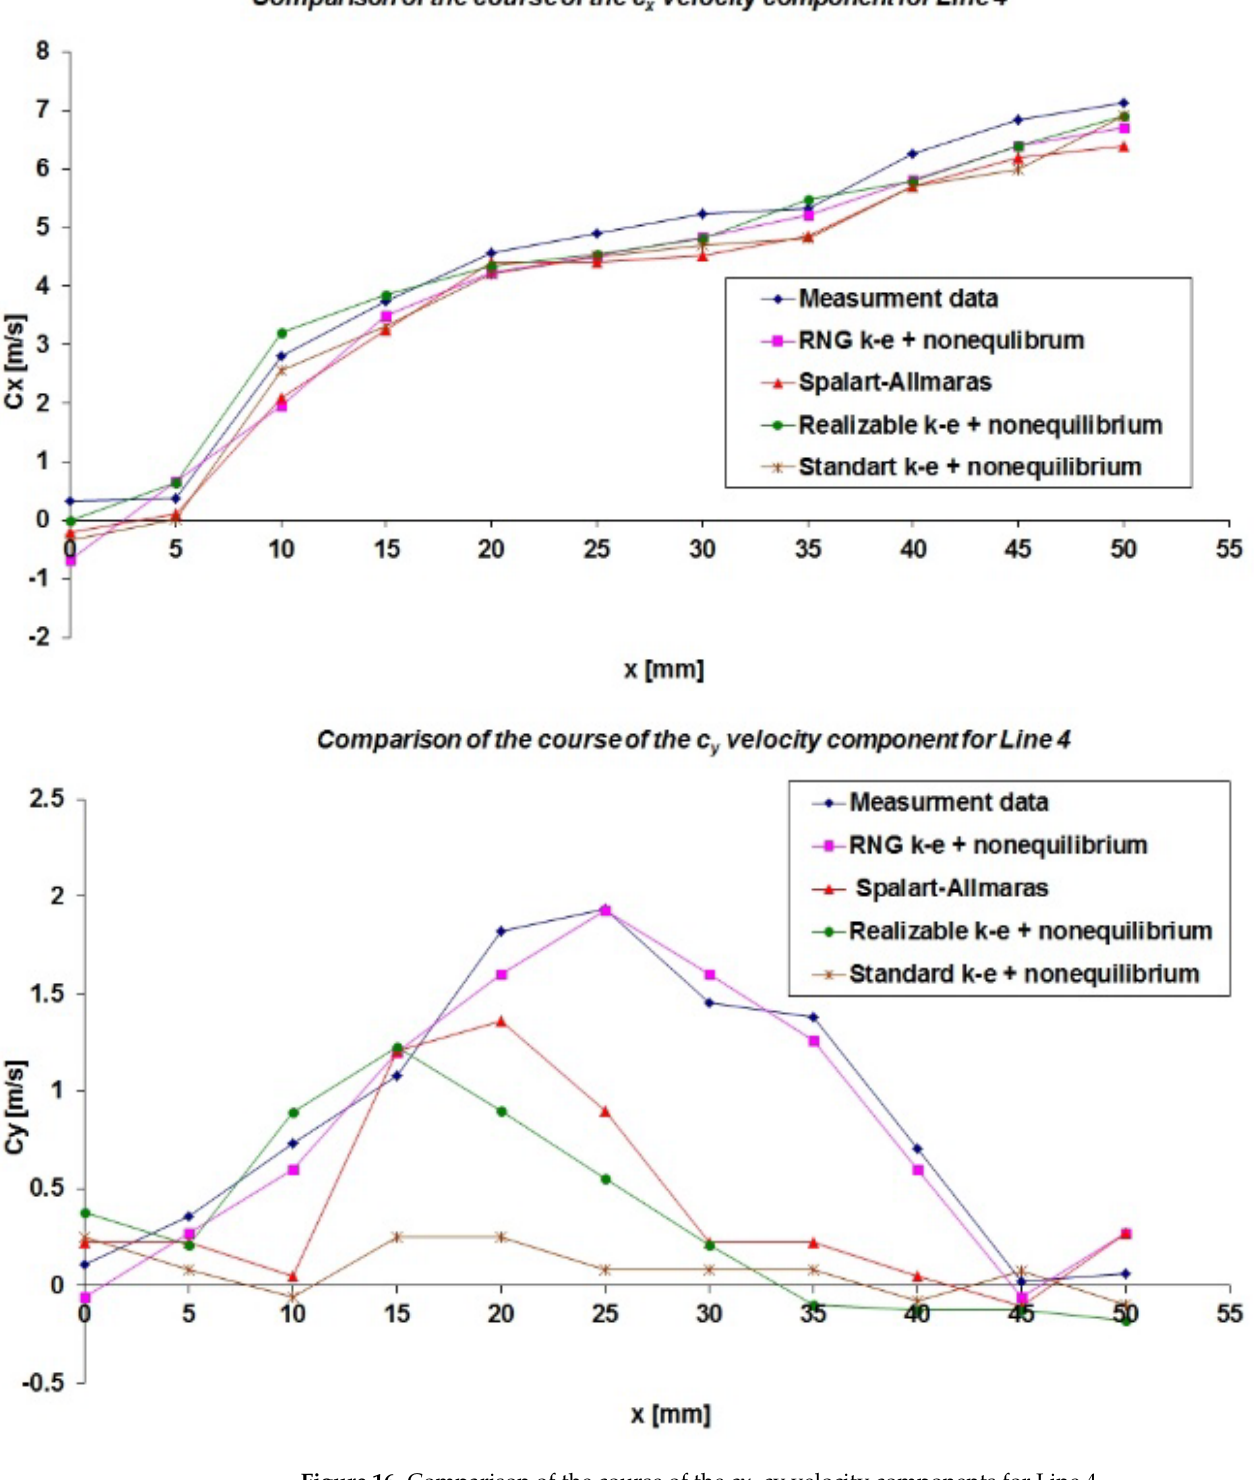
Figure 16. Comparison of the course of the cx, cy velocity components for Line 4.